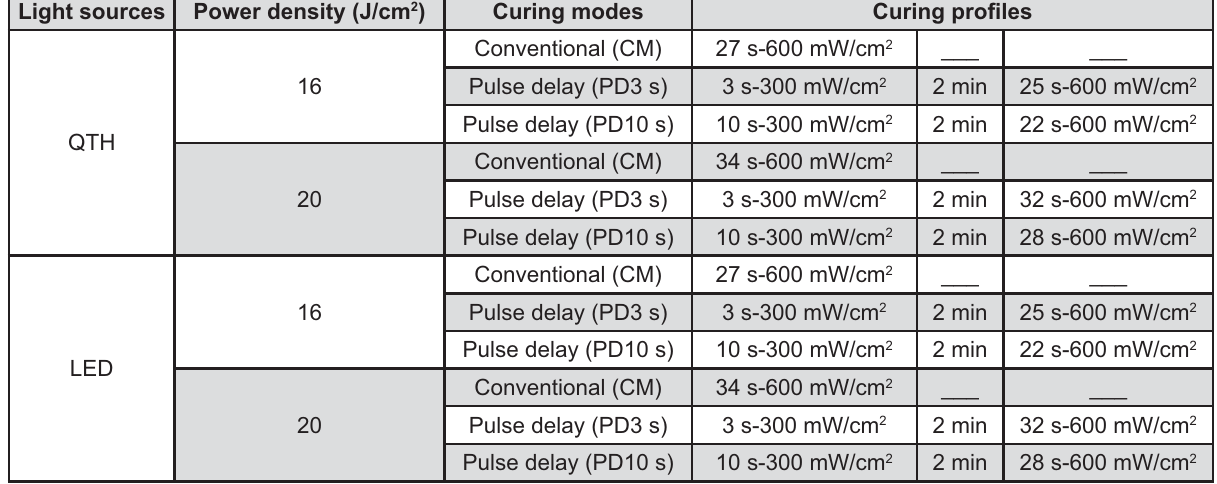
Figure 1- Details of the various light curing modes evaluated. Table 1- Means, standard deviations (±SD) for comparison between light source and permeant for the measurement of sorption and solubility at 16 J/cm 2 Interation